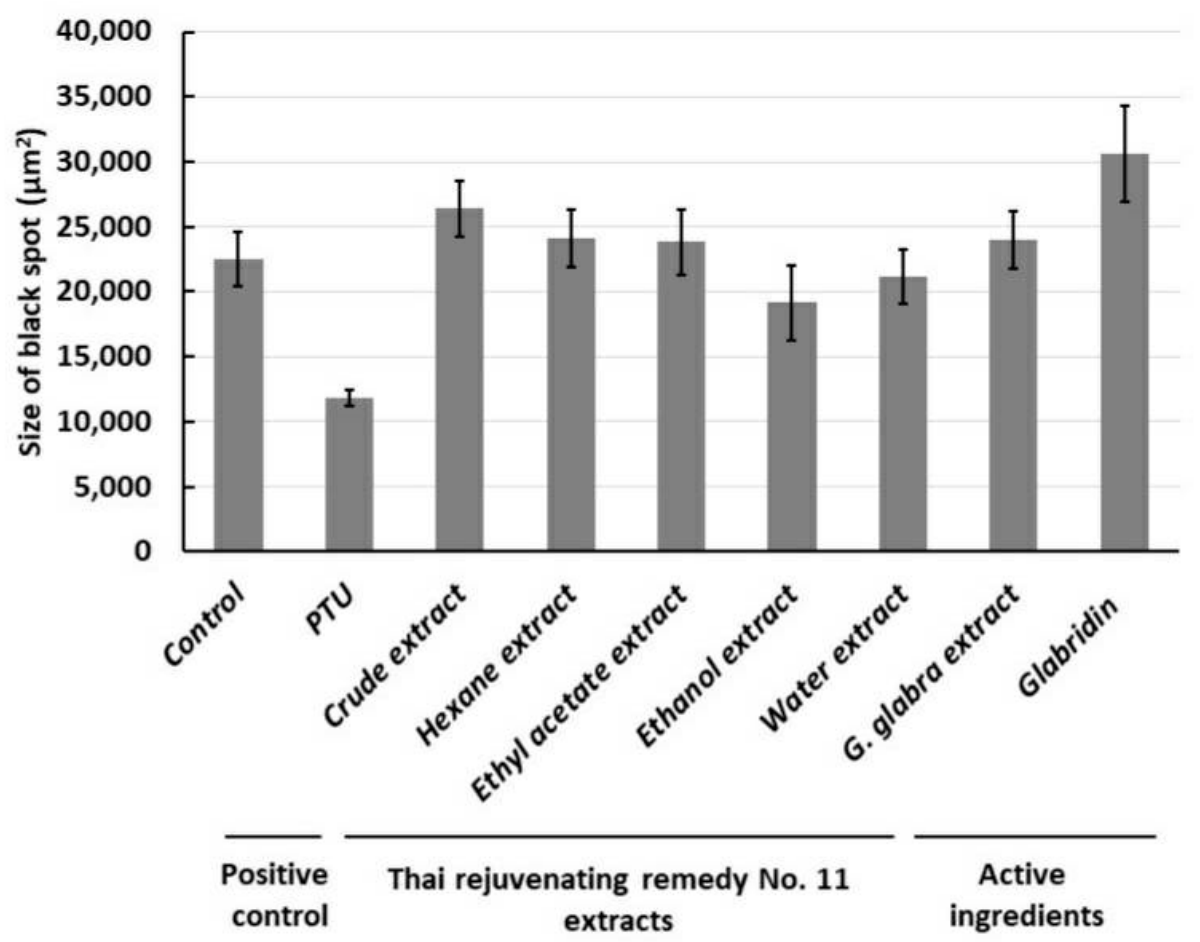
Figure 7. Anti-zebrafish larvae pigmentation of positive controls (1-phenyl-2-thiourea, PTU), Thai rejuvenating remedy No. 11 extracts (crude, hexane, ethyl acetate, ethanol, and water extracts), and active ingredients ( G. glabra and glabridin) at a concentration of 10 µg/mL. 0.03% sea salt solution is used as a negative control. All samples are tested in triplicate (N = 3).